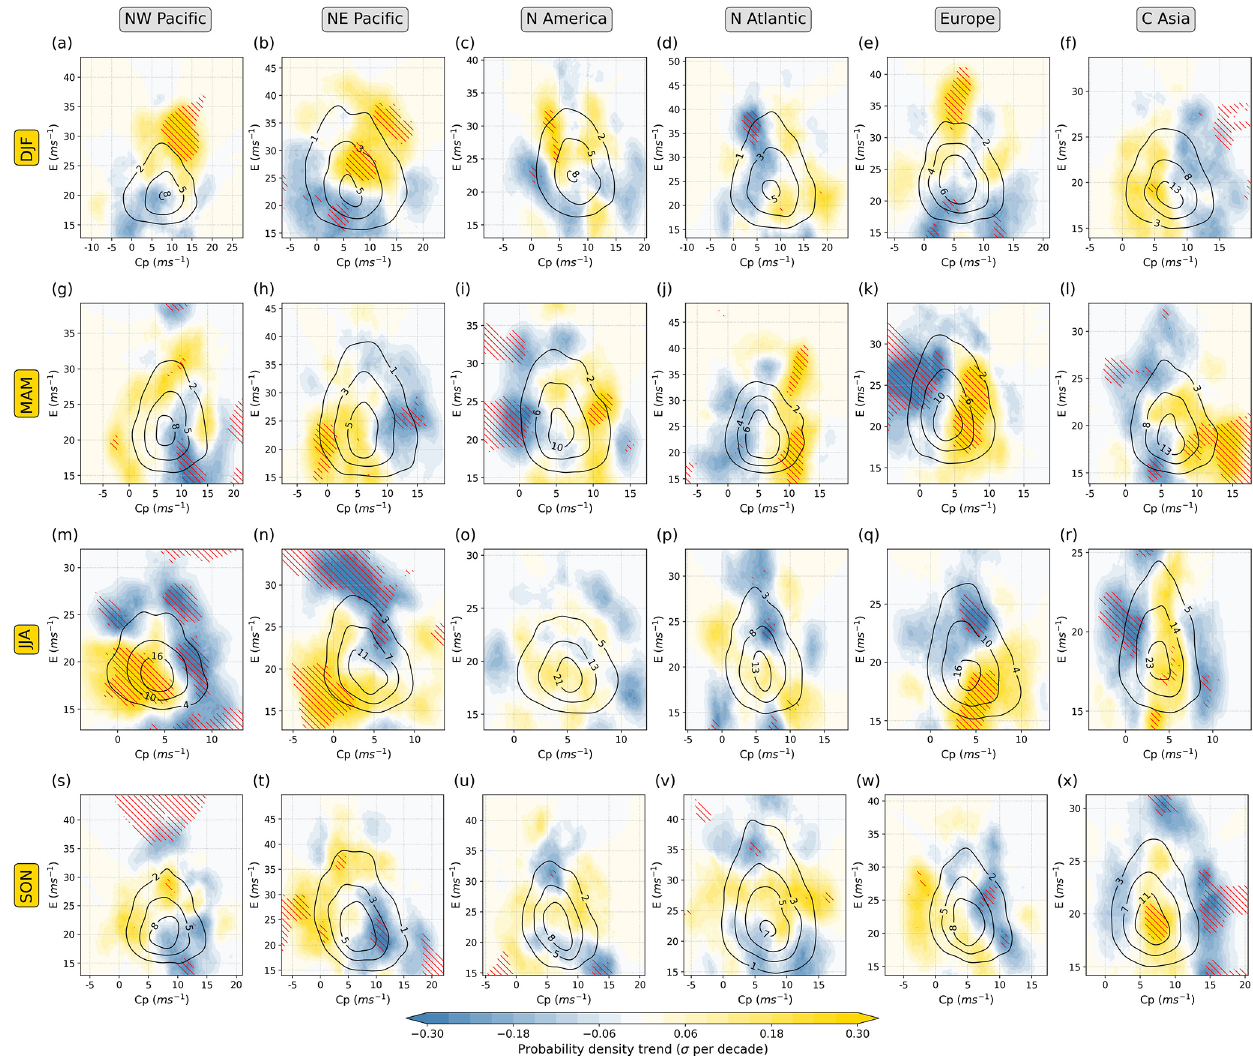
Figure 9. (a–f) Climatological (1979–2019) bivariate PDF of the DJF daily-mean E and c p at 300hPa (10 − 3 (ms − 1 ) − 2 ; black contours) over (a) the NW Pacific, (b) the NE Pacific, (c) N America, (d) the N Atlantic, (e) Europe, and (f) central Asia in ERA5. Colour shading corresponds to the 1979–2019 linear trend (Theil–Sen estimator) in the seasonal probability density of daily-mean E and c p . Red hatching indicates areas where the trend monotonicity is statistically significant at the 0.10 significance level. Panels (g–l) , (m–r) , and (s–x) are the same as panels (a–f) , but for MAM, JJA, and SON,